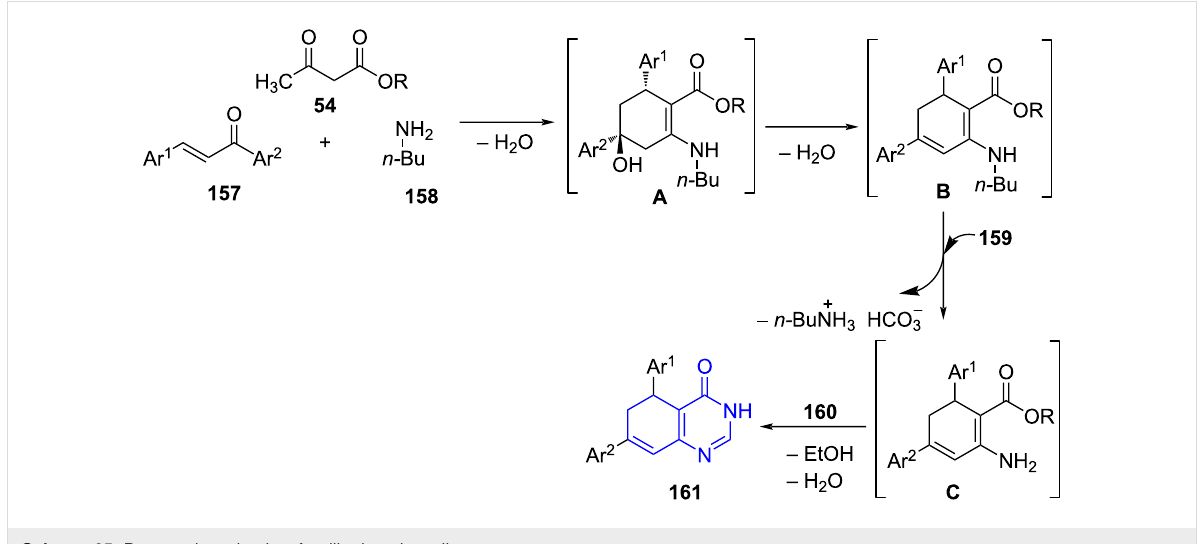
Scheme 65: Proposed mechanism for